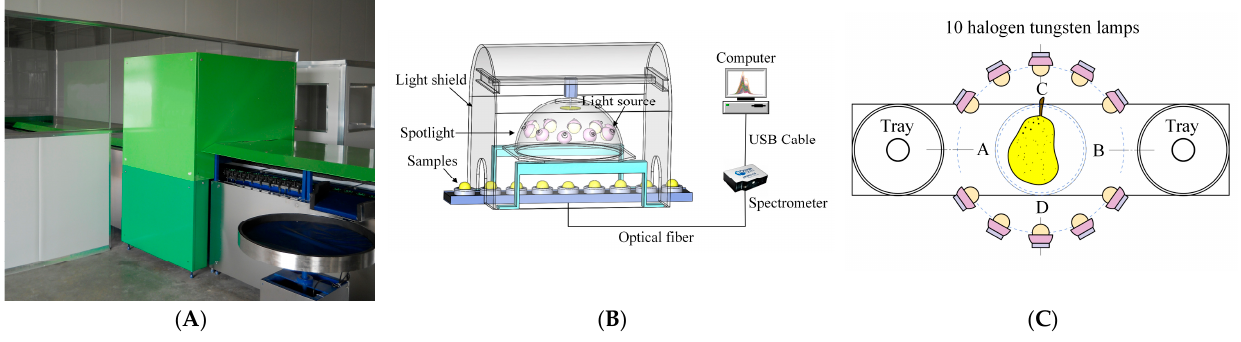
Figure 1. Dynamic online acquisition device of Yali pears: ( A ) device diagram; ( B ) core detection unit; ( C ) schematic diagram of arrangement and distribution of tungsten halogen lamps.